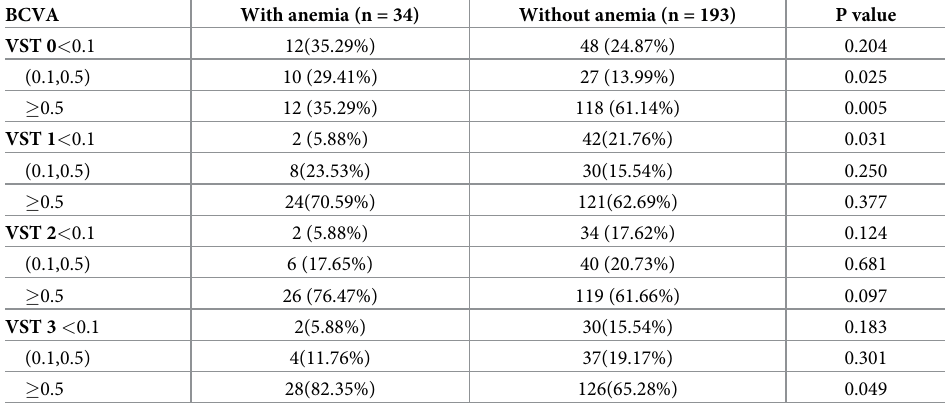
Table 3. Comparison of improvement of BCVA in the anemia group and non-anemia group. BCVA With anemia (n = 34) Without anemia (n = 193) P value VST 0 <